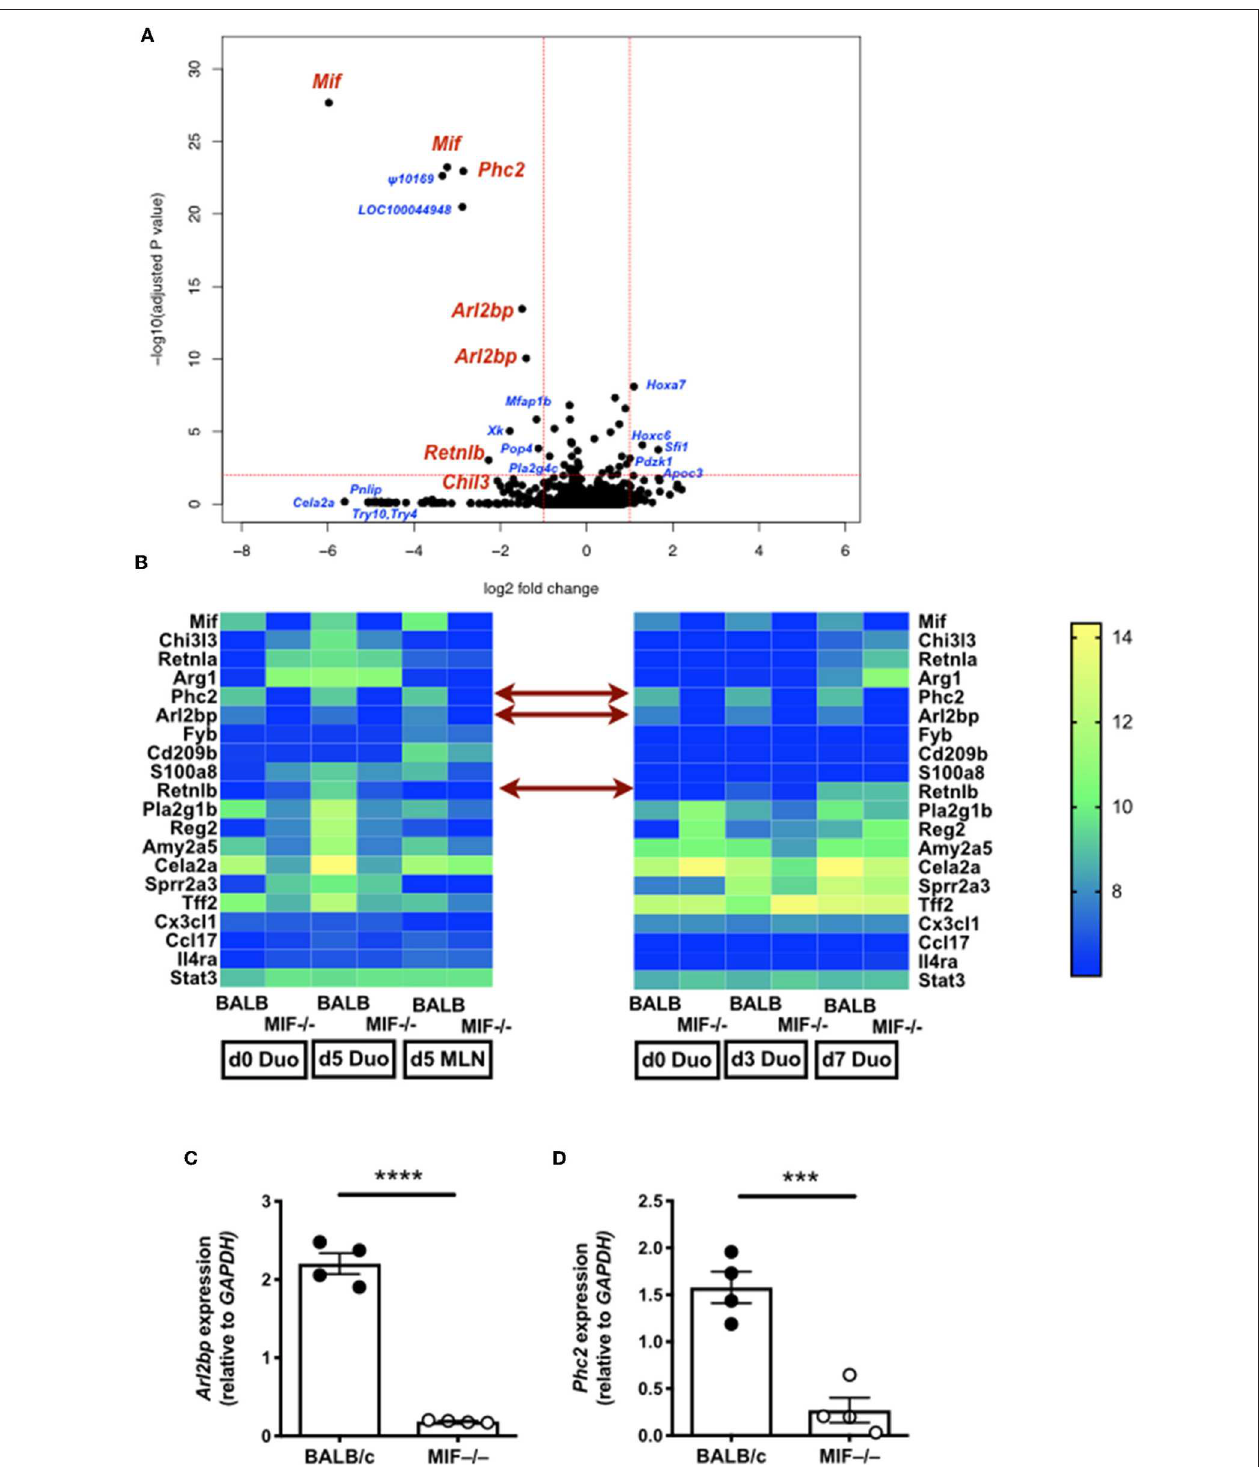
FIGURE 7 | Gene expression in H. polygyrus -infected MIF-deficient mice. (A) Volcano plot comparing gene expression in duodenal tissue from BALB/c and MIF − / − mice 5 days after H. polygyrus infection. Genes of interest are labeled in red; other loci showing large and/or significant changes are labeled in blue. (B) Heat maps from two gene expression experiments, on duodenal and MLN tissue for expression of selected genes 5 days after H. polygyrus infection in BALB/c and MIF − / − mice (left hand panel), and of duodenal tissues at days 3 and 5 post-infection in the same genotype mice (right hand panel). Expression levels are colored from blue (lowest) to yellow(highest) and in each case represent the mean of 4 replicates. (C,D) RT-PCR validation of Arl2bp (C) and Phc2 (D) . MLNs were harvested for analysis at d 5 of H. polygyrus infection, and subject to RT-PCR using gene specific primers. *** p < 0.001, **** p < 0.0001.